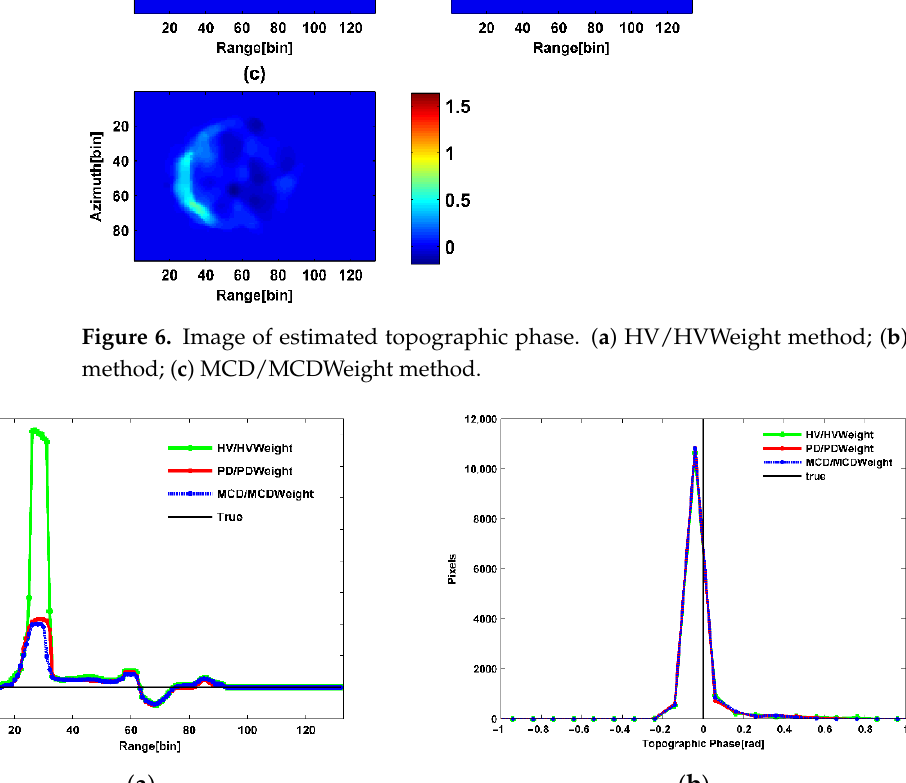
Figure 7. Profile and statistical histogram of the estimated topographic phase. ( a ) Profile of the estimated topographic phase; ( b ) Statistical histogram of the estimated topographic phase.